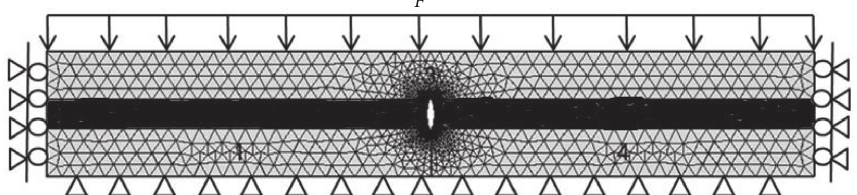
Figure 7: Geometric calculation model.